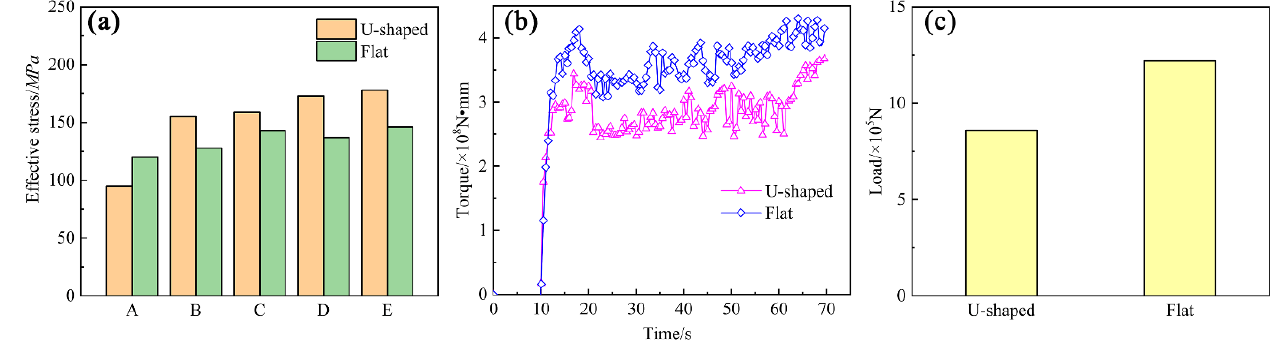
Figure 8. Simulated result: ( a ) Effective stress; ( b ) Torque of extrusion wheel; ( c ) Load of abutment.